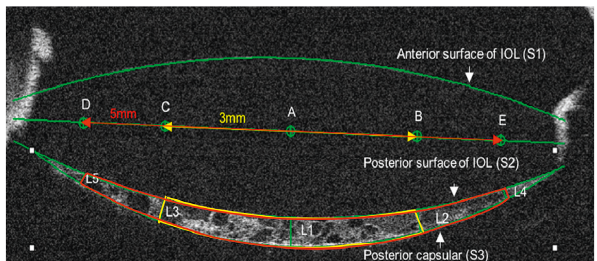
Figure 2: Illustration graph of the PCO evaluation method RTVue-100 OCT (the figure was acquired at the horizontal meridian from the same eye as in Figure 1). Measurement of PCO characteristics in one cross-sectional image. S: surface. Point A is the centre of the line (green line) that passed the horizontal or vertical centre of the IOL, which is the centre of the IOL optic region. Distance between points B and C is defined as the 3mm diameter range of the IOL optic region (yellow arrow line), while the red line between points D and E is the 5mm range (red arrow line). S1 is the anterior surface of the IOL, S2 is the posterior surface of the IOL, and S3 is the posterior capsule. The crescent- shaped space between S3 and S2 is the IOL-posterior capsular space, which is the space over the full 6mm diameter. The lengths of L1, L2, L3, L4, and L5 are PCO thicknesses at the point of the central optic region and at the 3mm and 5mm diameter of the IOL optic region. The area between L3, L2, S2, and S1 is the PCO region at the 3mm diameter range of the IOL optic region (indicated with a yellow line), while the area between L4, L5, S2, and S3 is the PCO region at the 5mm diameter range of the IOL optic region (indicated with a red